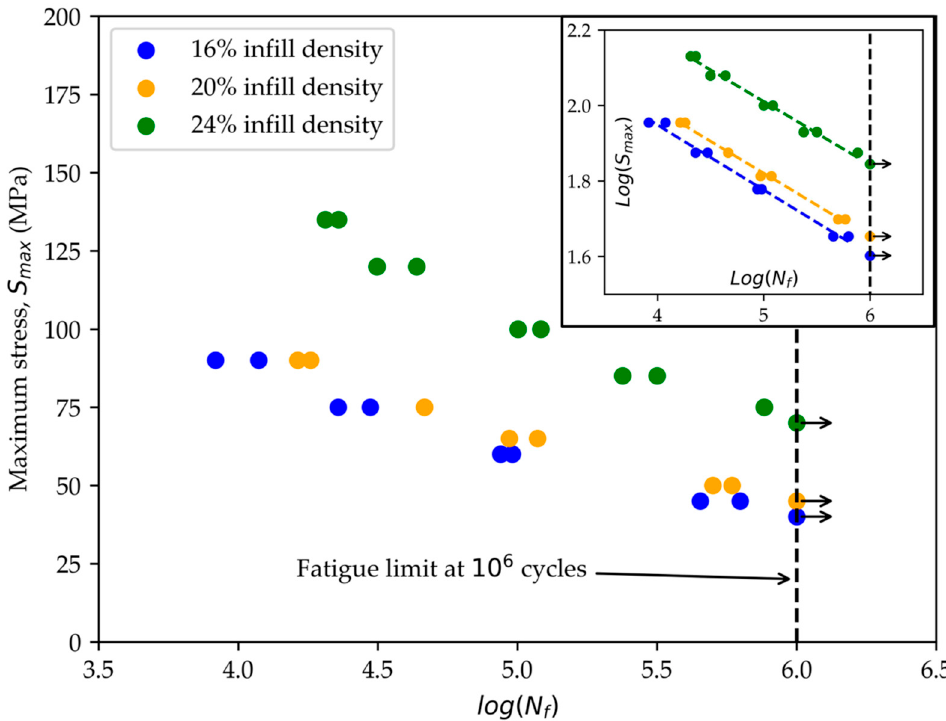
Figure 13. S–N curves of 316L infill specimens with different densities in a linear–log plot and linear fitting in a log–log plot.